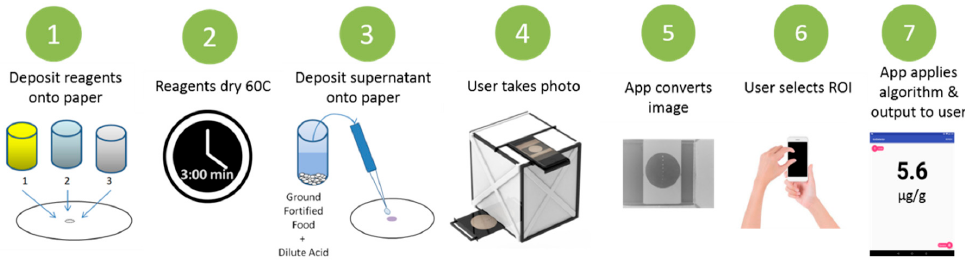
Figure 1. Schematic for the recommended procedure for preparing the paper-based assay, sample deposition, and analysis.